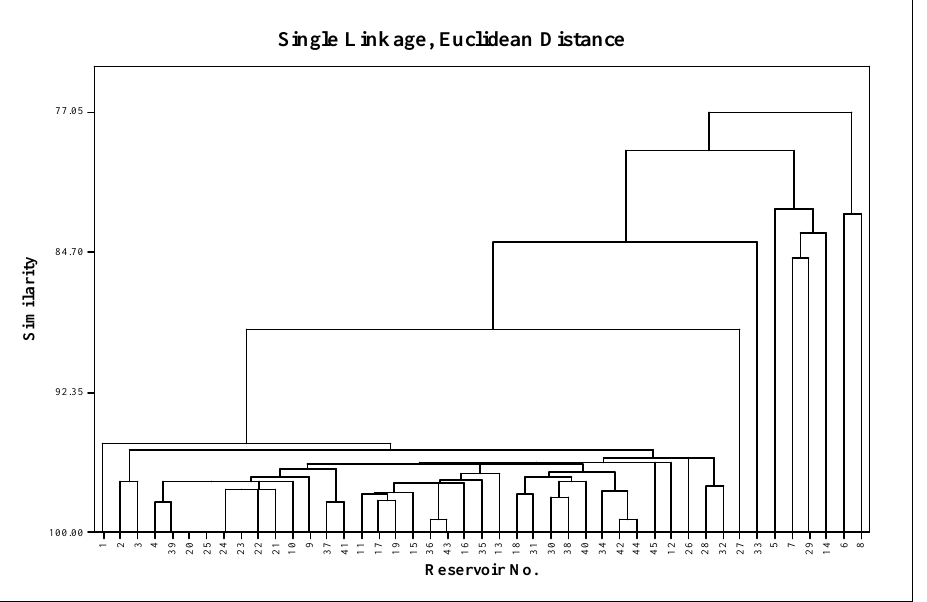
Figure 4: Dendogram showing the similarity of study sites based on environmental